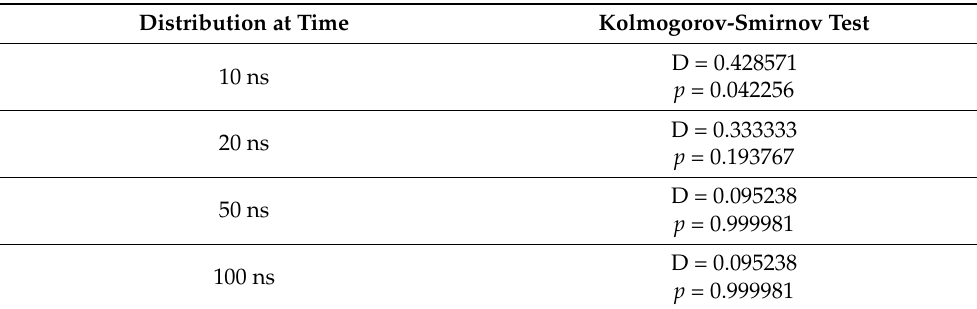
Table 1. Kolmogorov–Smirnov statistical tests for comparison of spatial (radial) distributions obtained with the compartment-based and particle-based simulations.